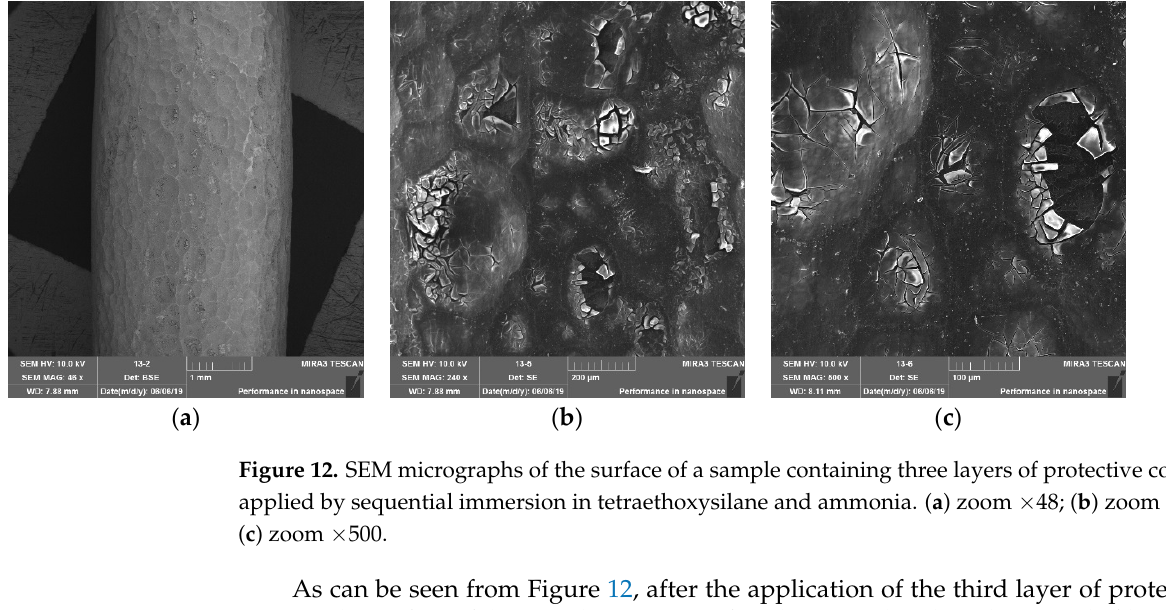
Figure 11. SEM micrographs of the surface of a sample containing one layer of protective coating applied by sequential immersion in tetraethoxysilane and ammonia. ( a ) zoom ×46; ( b ) zoom ×100; ( c ) zoom ×64,000.